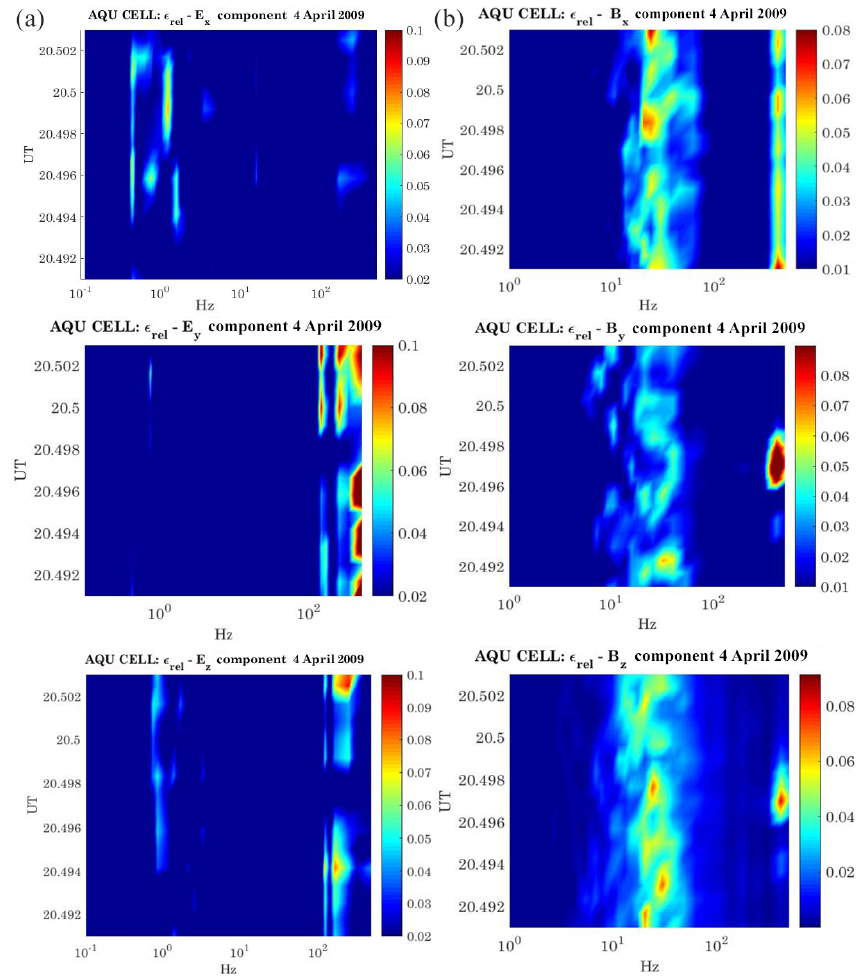
Figure 6. Anomalous event detected over L’Aquila on 4 April 2009. (a) shows the (cid:15) rel ((cid:96)) vs. time and frequency for the three components of the electric field; (b) shows the (cid:15) rel ((cid:96)) vs. time and frequency for the three components of the magnetic field. A clear anomalous energy peak at 333Hz, with respect to the quiet reference conditions (Fig. 4), appears in both magnetic and electric